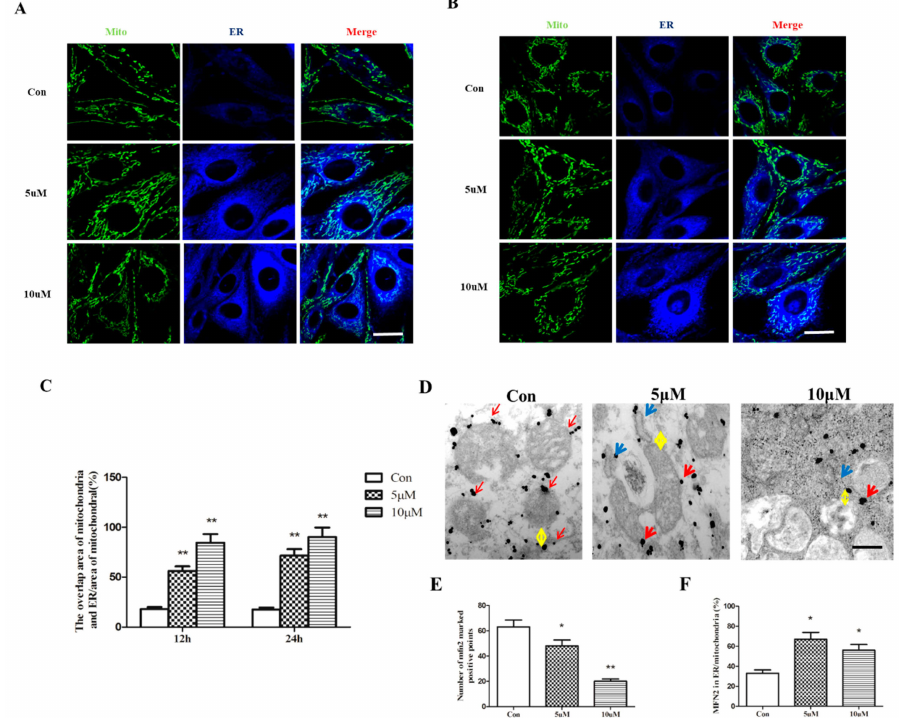
Figure 4. Pb exposure leads to enhanced ER–mitochondria interaction. PC12 cells were treated for 12 h and 24 h with graded concentrations of Pb. ER and mitochondria were labeled with ER- tracker (blue signal) and Mito-tracker (green signal); their localization and co-expression were de- tected under confocal laser microscope ( A , B ). The overlapping area of ER and mitochondria was quan- titatively analyzed after Pb exposure ( C ). Distance between ER (indicated by blue arrows) and mito- chondria (indicated by yellow arrows) was detected by Immunogold-labeled electron microscopy ( D ). Moreover, the distribution of MFN2 (indicated by red arrows) in cells was detected by colloidal